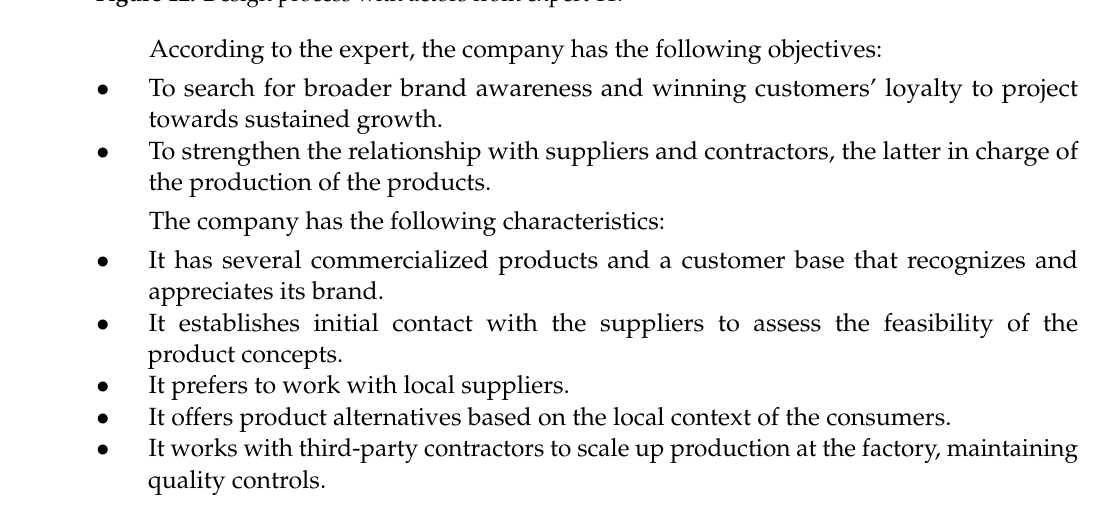
Figure 13. Design process with actors from expert 11. Figure 12. Design process with actors from expert